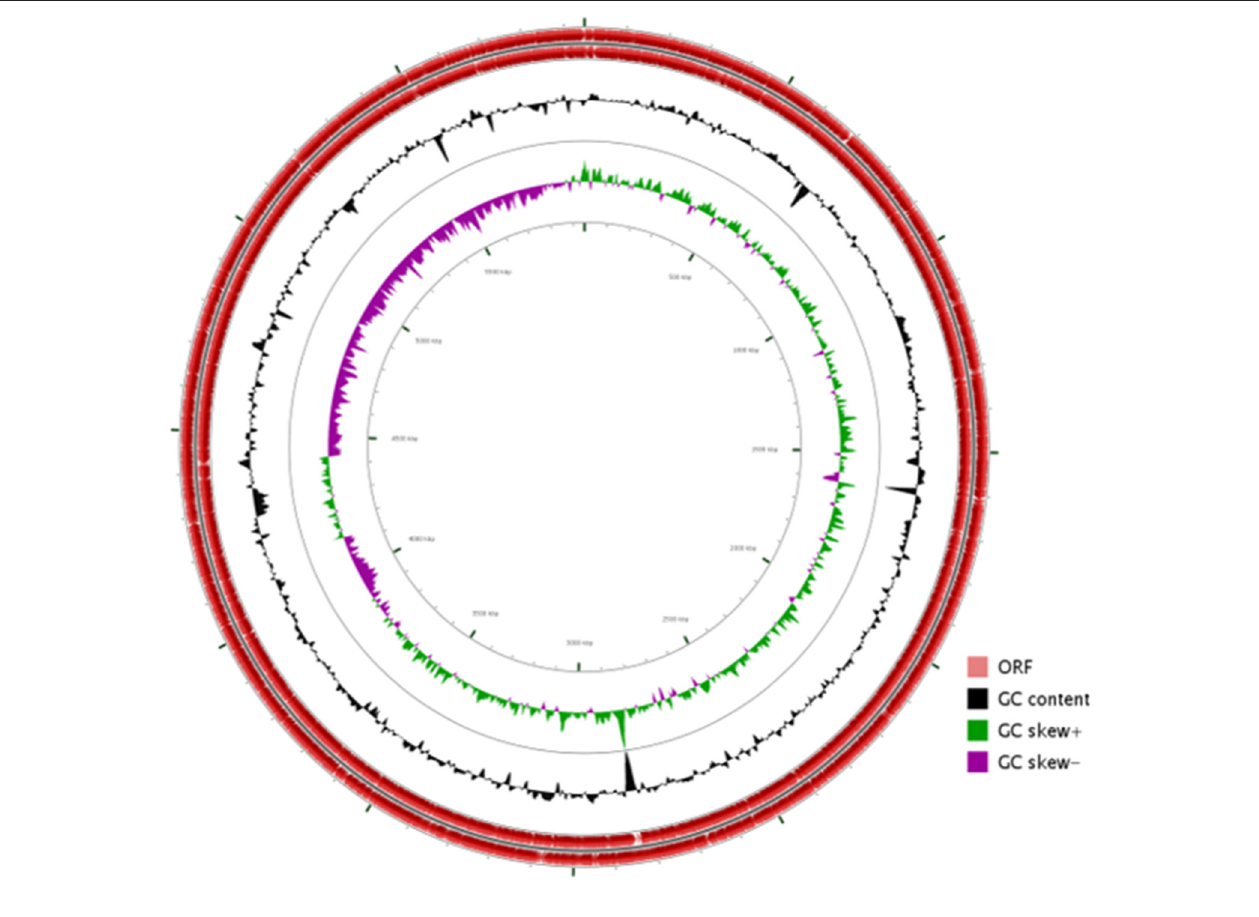
FIGURE 2 | Circular representation of P. rhizophila S211 genome generated by CG viewer. Circles from outside to inside: first, scale bar in kilobases; second and third, predicted coding sequences of chromosome on leading and lagging strands; fourth, GC content; fifth, GC